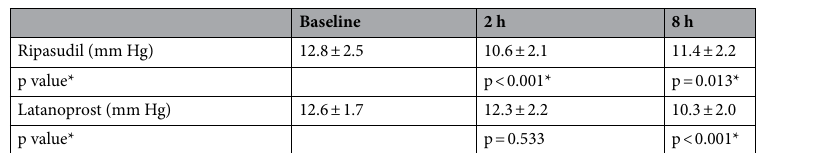
Table 3. Intraocular pressures before and after the administration of ripasudil or latanoprost. Intraocular pressure is mean ± standard deviation. *Within-group comparison to baseline.